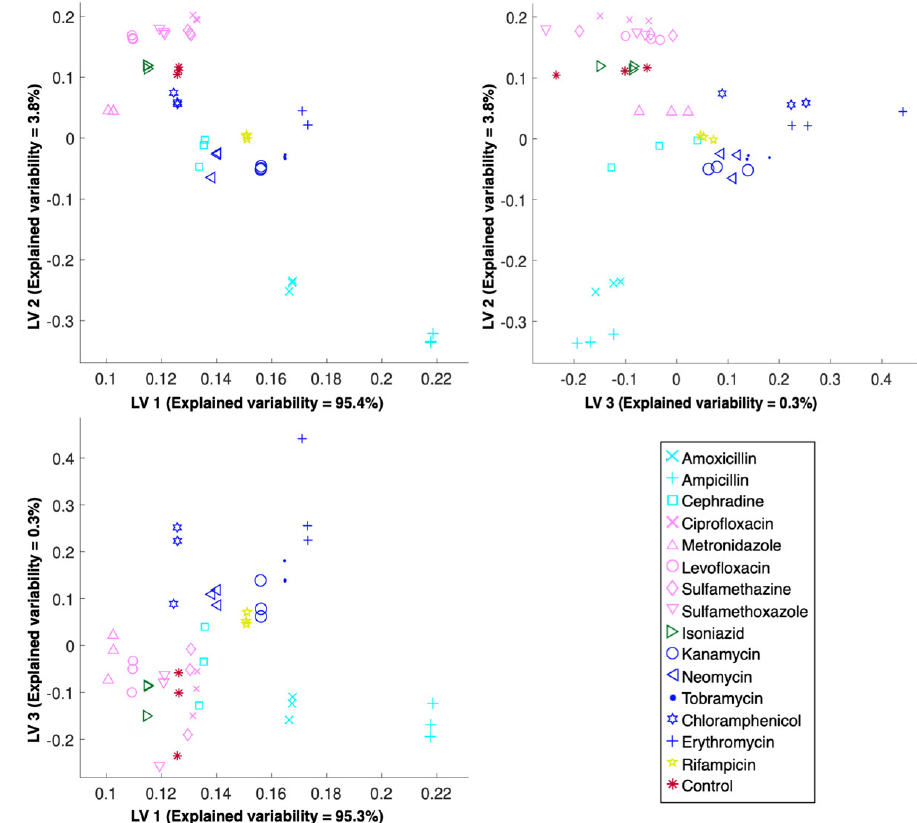
Figure 3. Representation of the metabolic fingerprints induced by antibiotics acting on the major biosynthetic pathways after Partial Least Squares Discriminant Analysis (PLS-DA), preceded by an optimized combination of preprocessing algorithms. The variability explained by each Latent Variable (LV) is reported for each corresponding axis. Antibiotics acting on the same major biosynthesis pathway are represented using the same color, and individual antibiotics are represented with a unique symbol.